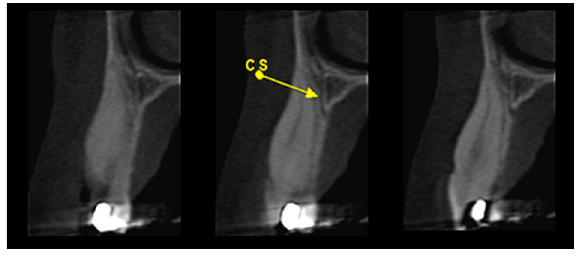
Figure 2. Example of CS presence in CBCT cross-sections in the 13th tooth